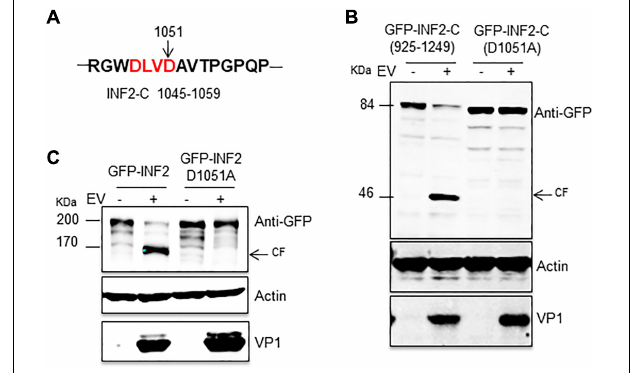
FIGURE 4 | INF2 was cleaved at Aspartic 1,051 in EV71-infected cells. (A) Schematic diagram showing the sequences of 1,045–1,059 amino acids. The typical caspase cleavage residues are highlighted in red font. (B) RD cells were transfected with plasmids encoding GFP-INF2-C (925–1,249) or GFP-INF2-C (D1051A), 24 h after transfection, the cells were infected with EV71 (MOI = 10) for the indicated times (hpi, h post-infection), and then the cells were harvested, and Western blot was performed using the indicated antibodies. Arrows indicate the cleavage fragments (CF). (C) RD cells were transfected with plasmids encoding GFP-INF2 or GFP-INF2 (D1051A); then, they were treated as described in (B) .